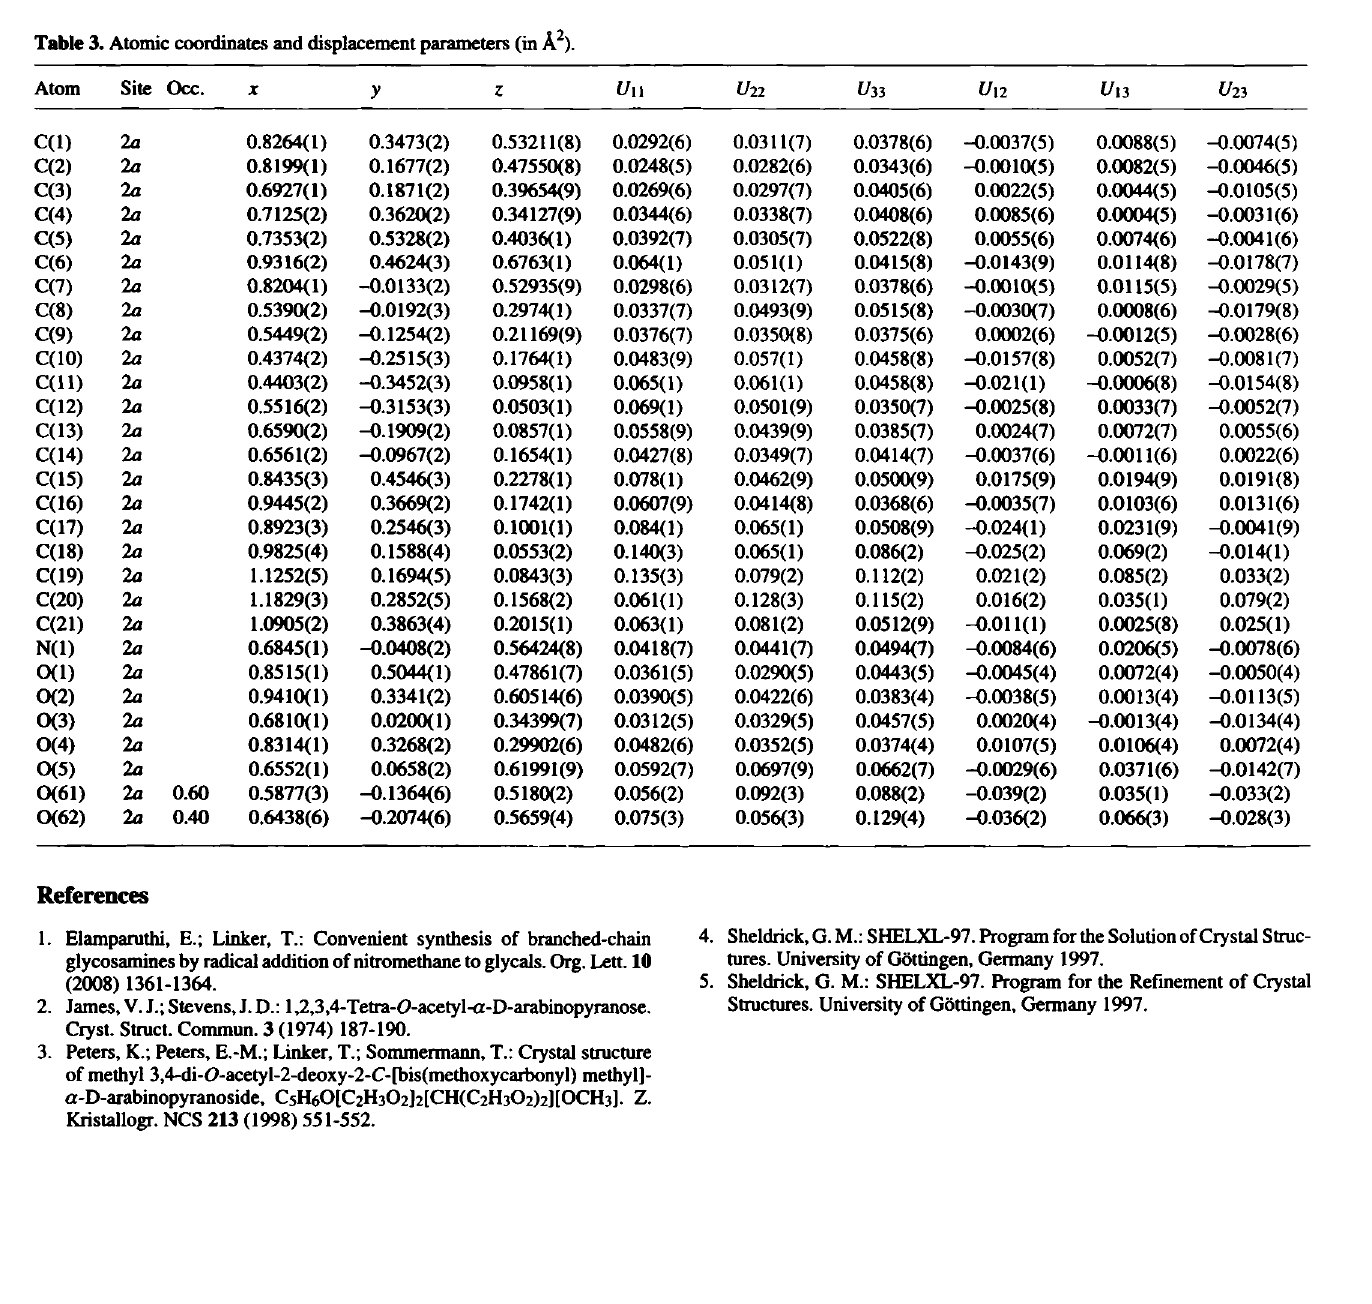
Table 3. Atomic coordinates and displacement parameters (in Â 2